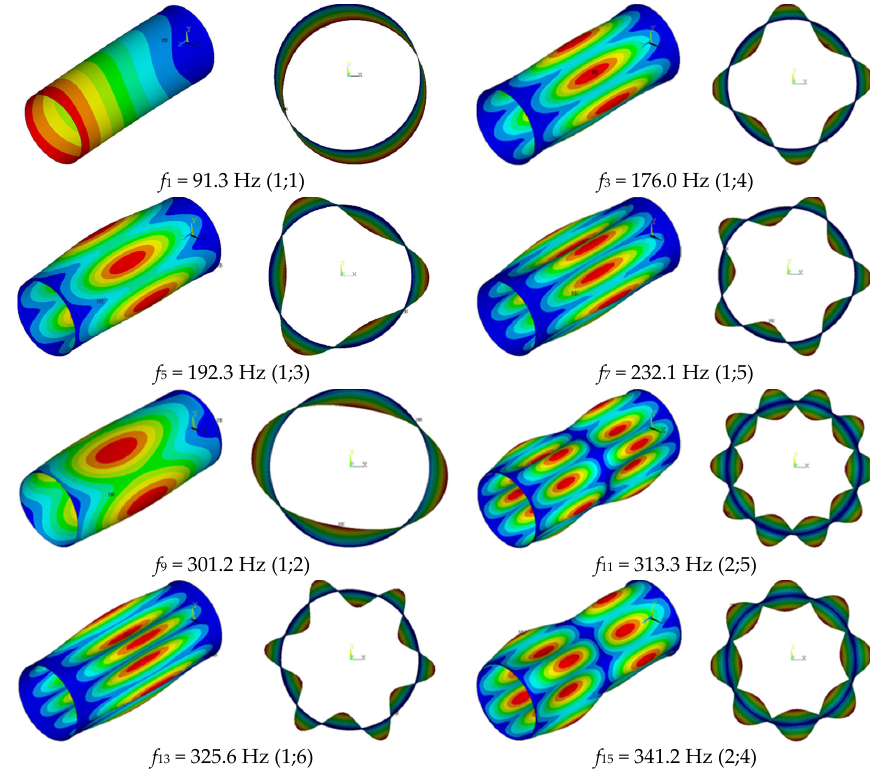
Figure 5. Fundamental vibration mode shapes and corresponding frequencies.